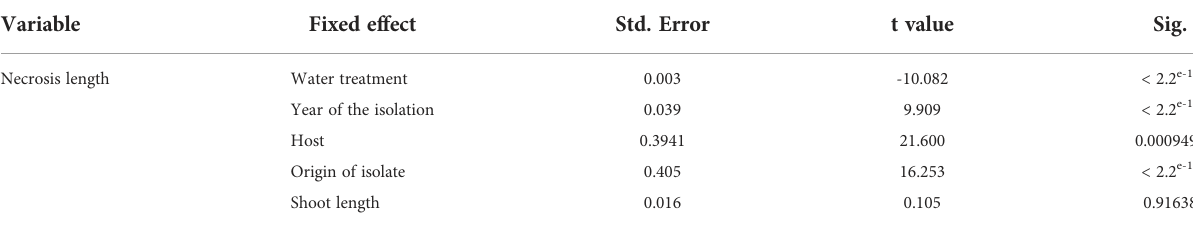
TABLE 2 Statistical analysis of the necrosis length between the different water treatments, year of isolation, the different hosts, host origin and shoot length. Variable